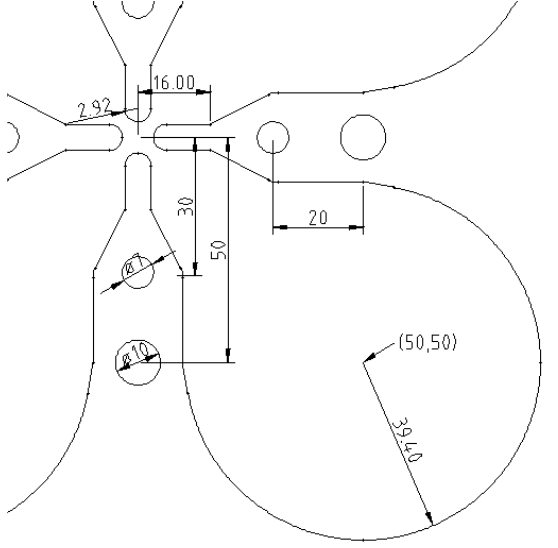
Figure 9. Sketch of a portion of the RFQ cross section, show- ing some dimensions (all in mm). The vane tips geometry comes from the average values of the modulation and the cooling chan- nels position and diameter, that restrict vane thickness due to im- pose a minimum wall thickness, are fixed values. All the other parameters were subject of optimization.